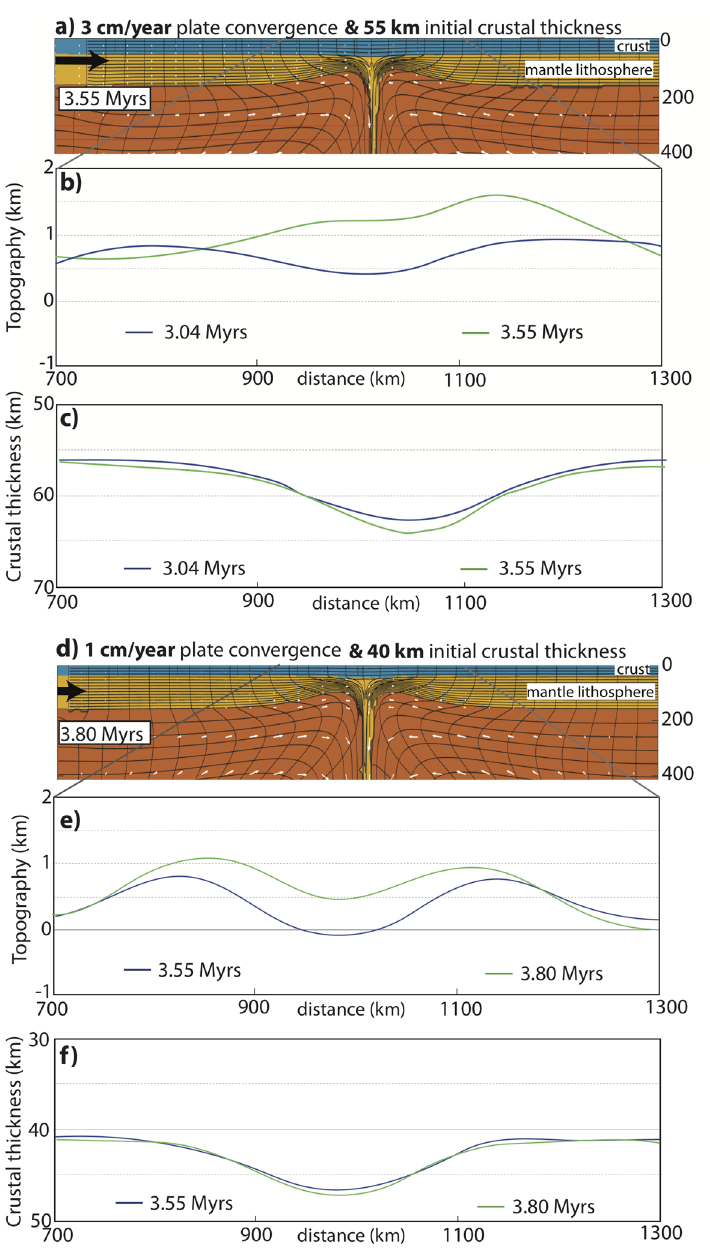
Figure 3. ( a ) Geodynamic configuration of lithospheric removal model for timeframe 3.55 Myrs. Plate convergence velocity Vp = 3 cm/year is applied on the left boundary of the model domain. ( b ) Topographic evolution for timeframes 3.04 and 3.55 Myrs, ( c ) Crustal thickness variations for each timeframes shown in ( b ). ( d ) Geodynamic configuration of lithospheric removal model for timeframes 3.80 Myrs. Plate convergence velocity Vp = 1 cm/year is applied on the left boundary of the model domain but the initial crustal thickness is reduced to 41.5 km (approximately global average). ( e ) Topographic evolution for timeframes 3.55 and 3.80 Myrs, ( f ) Crustal thickness variations for each timeframes shown in ( b